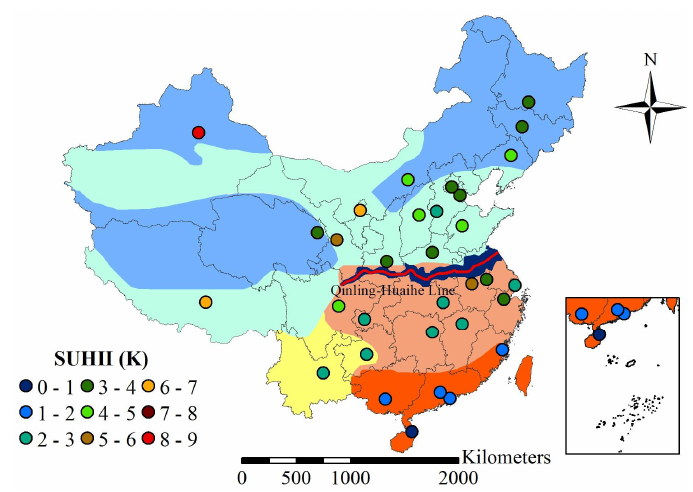
Figure 6. Spatial patterns of annual averaged daytime SUHII in summer during 2003–2013.